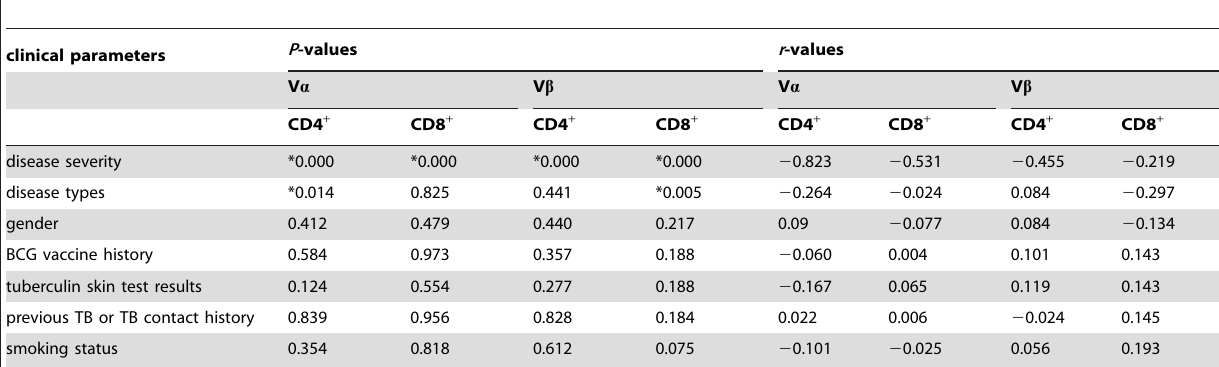
Table 4. The correlation of relative complexity scores and clinical parameters.